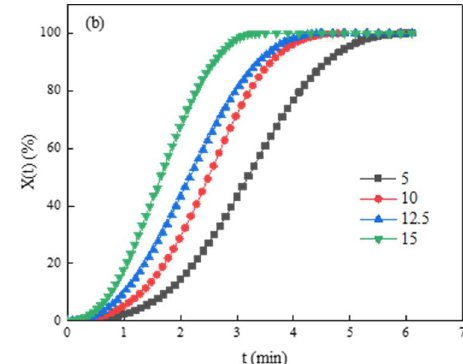
Figure 3. X(t)-t curves of PET. ( a ) PET; ( b ) PSLDH 0.01 wt%; ( c ) PSLDH 0.03 wt%; ( d ) PSLDH 0.05 wt%; ( e ) PSLDH 0.07 wt%; ( f ) PSLDH 0.1 wt%.